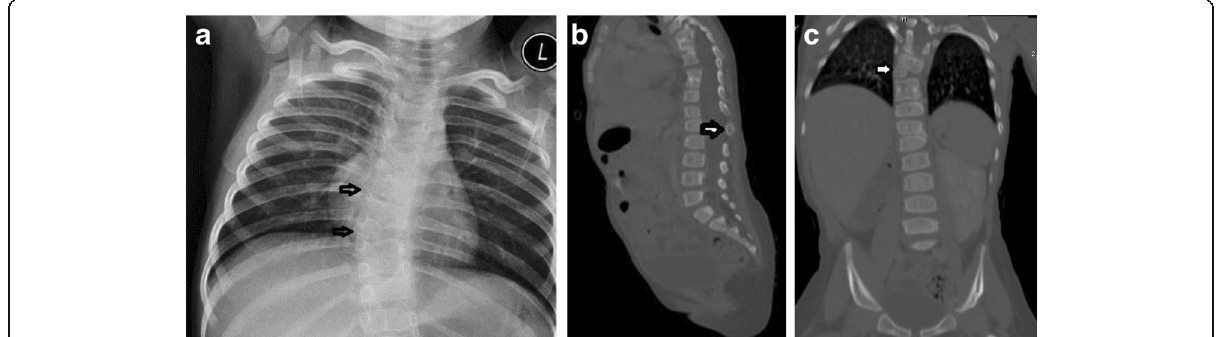
Fig. 2 a Posterior-anterior chest X-ray showing thoracic vertebral anomalies. b and c Sagittal and coronal chest, abdomen, and pelvis CT scan showing vertebral anomalies non-visualization of the right kidney